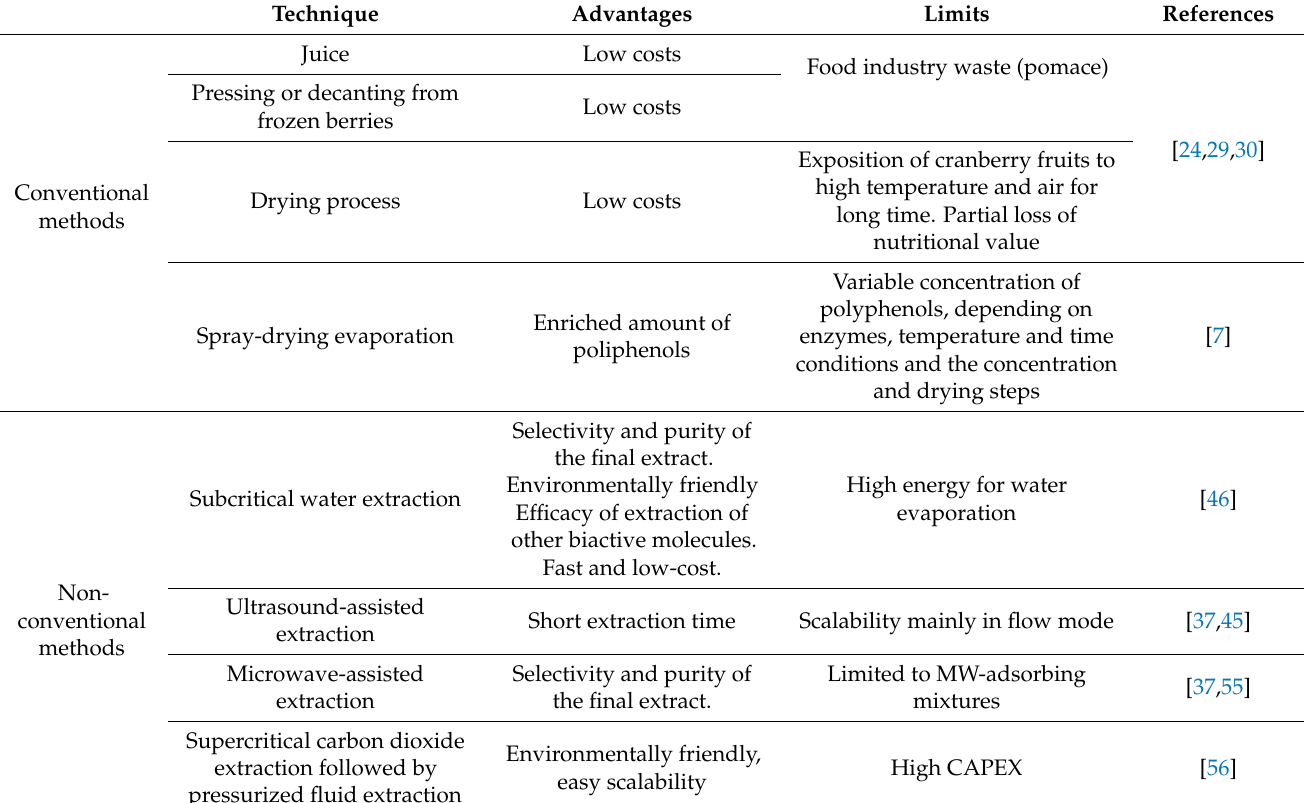
Table 4. Advantages and limits of polyphenols extraction from cranberry using classic or non-conventional techniques. Technique